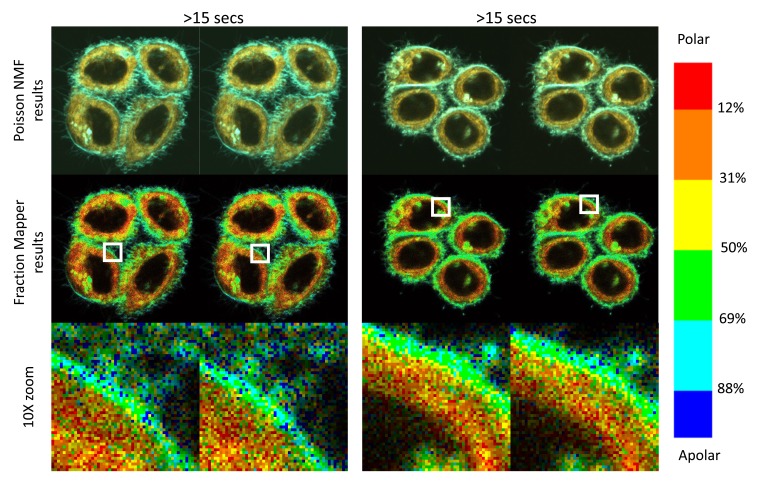
Using 2 sequential acquisitions 15 seconds apart to ensure that the acquisition has not modified the membranes or damaged the cells.Hela cells grown for two days on glass coverslips were stained with 200 nM C-laurdan and imaged twice sequentially with the standard conditions defined in M&M (power 4%, speed 6, 4 averages, pinhole 150). With these setting, the acquisition procedure takes 15 seconds. The second picture is thus taken 15 seconds after the first one. Z4:Whole image : 53 µm, 1 pixel = 100 nm HELA C Laurdan 200 nM, Laser at 720 nm, Z4, power: 4%, speed: 6 (6 usec/pixel), average on 4 measures, pinhole: 150 Hela CL 4 and Hela CL 5 15 Oct 2015.